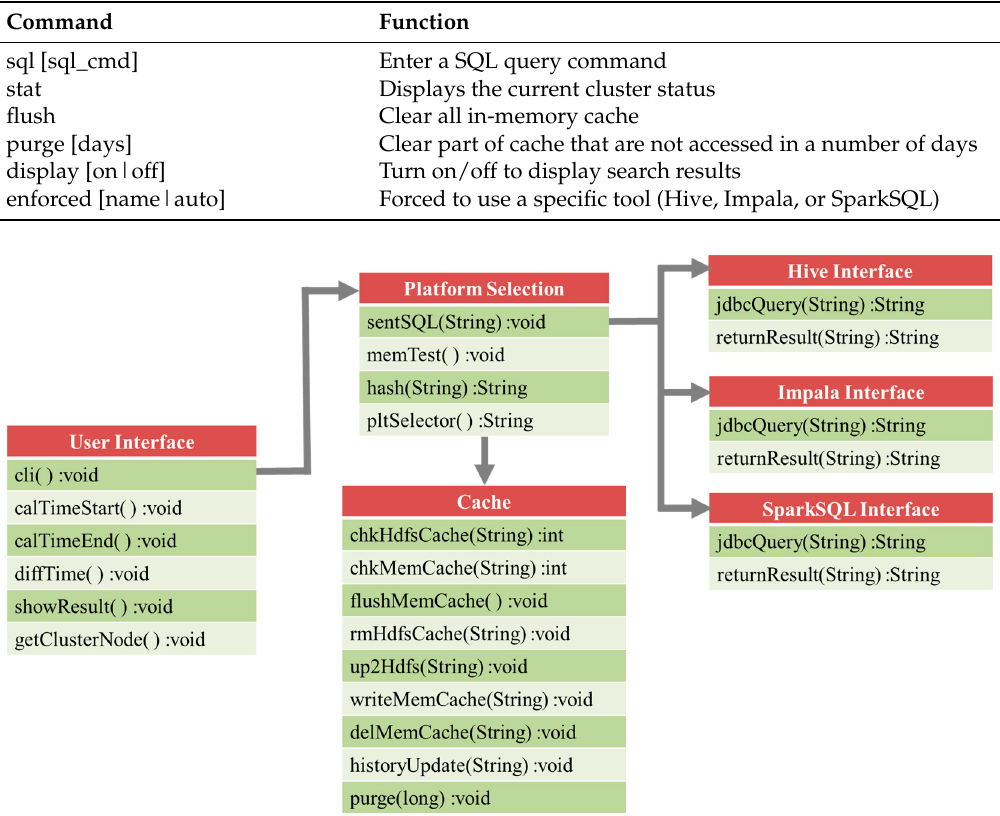
Table 4. A list of instructions for a command line interface in system.